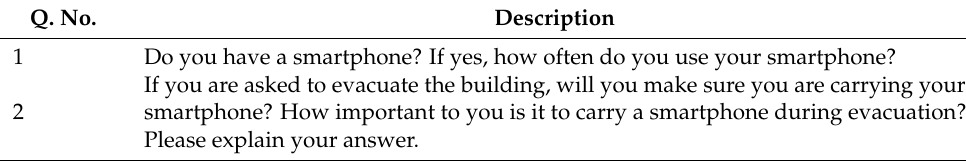
Table 2. Semi-Structured Interview